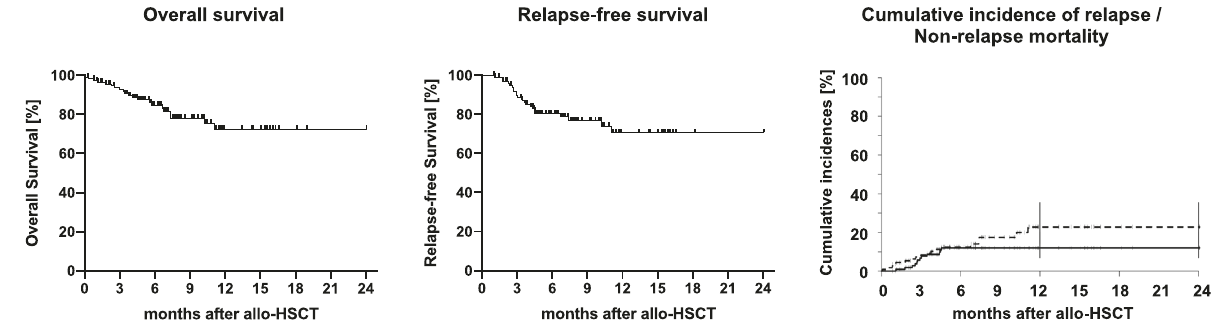
Fig. 3 Overall (OS), relapse-free survival (RFS), cumulative incidences of relapse (CIR), and non-relapse mortality (NRM) of the transplant cohort. With a median FU of 7.6 months (range: 0.1 – 24.1 months) estimated 2-year OS, RFS, CIR, and NRM probabilities of the entire cohort were 73%, 71%, 23%, and 12%, respectively. OS was estimated as time between allo-HSCT and death or date of last follow-up in surviving patients, while RFS was calculated as time from allo-HSCT until relapse or death without relapse censoring those patients, who had not relapsed until and were alive at date of last follow-up. CIR and NRM were considered as competing risks and calculated using cumulative incidence (CI) estimates employing Gray test for univariate comparisons.